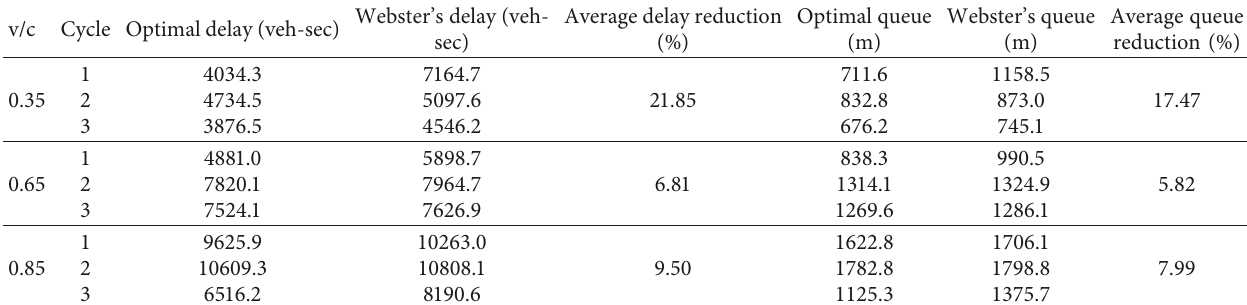
Table 5: Percent comparison of Model I relative to Webster’s design across different degrees of